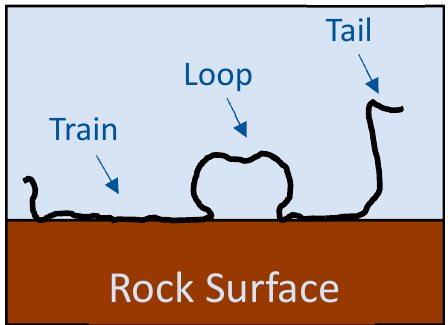
Figure 6. Hypothetical conformation of an adsorbed polymer molecule on a rock surface (adapted from [129]).